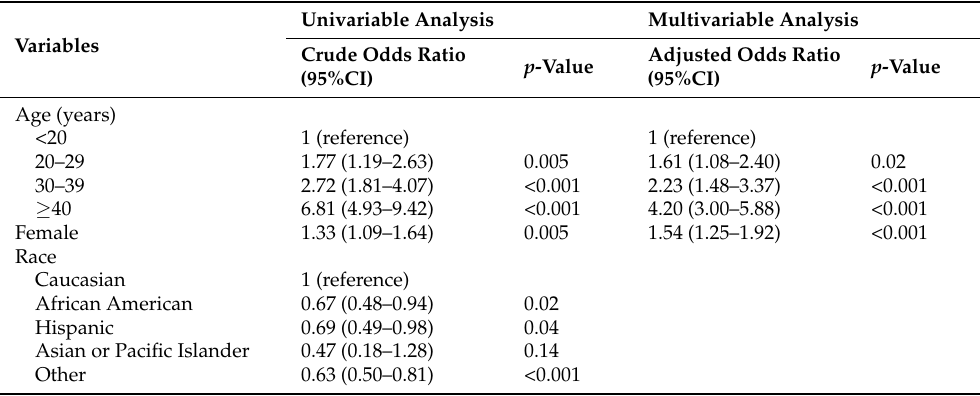
Table 2. Factors associated with circulatory shock in salicylate intoxication